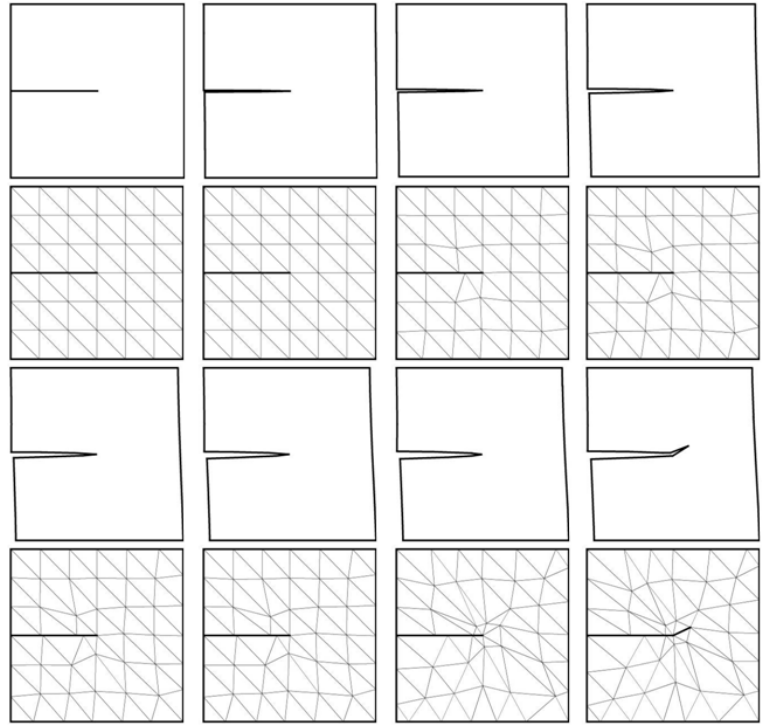
Figure 19: Kinking of a straight crack in mixed mode I & II. Mesh size: L/16 2 . Minimal deformation and modified mesh at 8 time steps. Crack kinking in the last